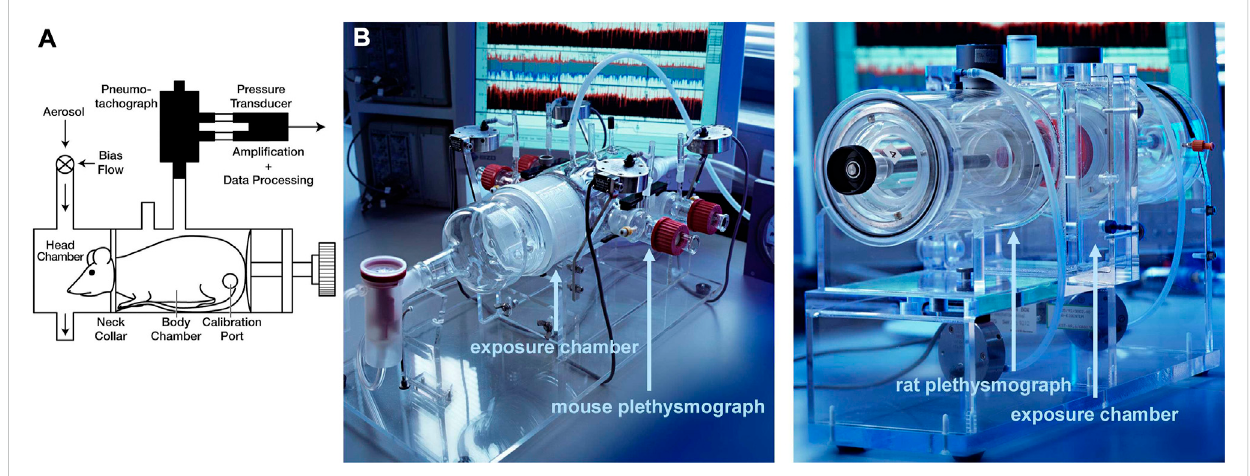
FIGURE 2 Head-out plethysmography (A) Schematic and (B) Photos of head-out plethysmography systems for mice and rats [reprinted from Hoymann.